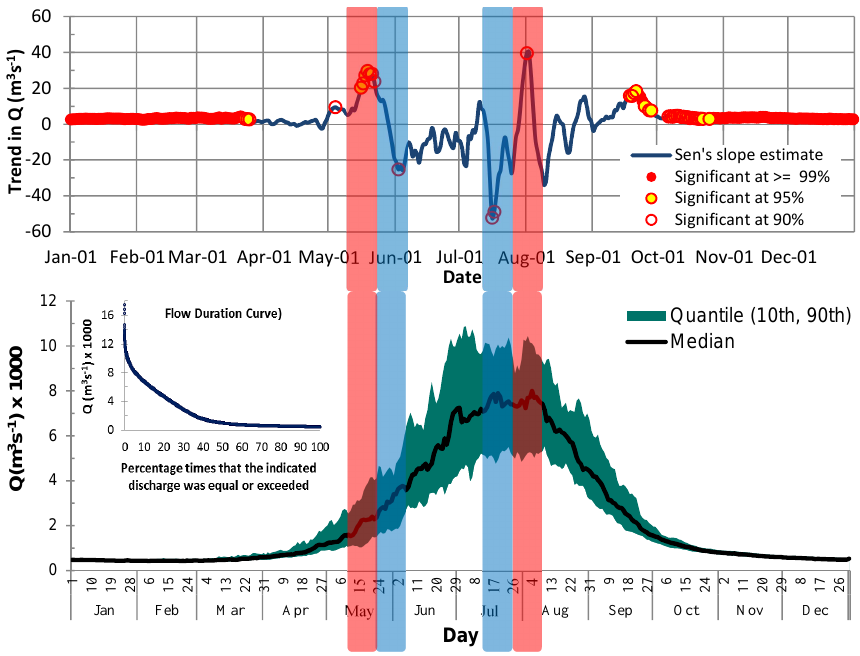
Figure 5. Long-term trends and variability of the UIB hydrological regime at the Besham Qila site. The blue bars indicate the times of a year when the UIB hydrological regime features significant negative trends while the red bars indicate the opposite. Inset shows the flow duration curve.